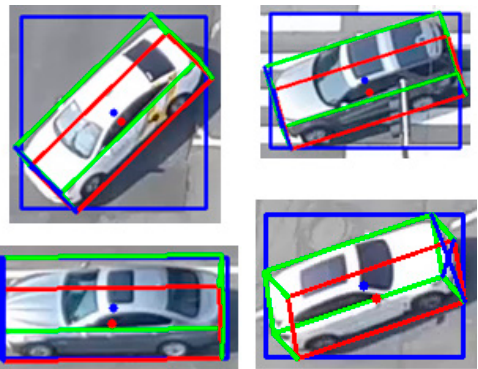
Figure 5. The blue circle is the center of the 2D detection window, and the red circle is the center of the bottom face of the 3D box.